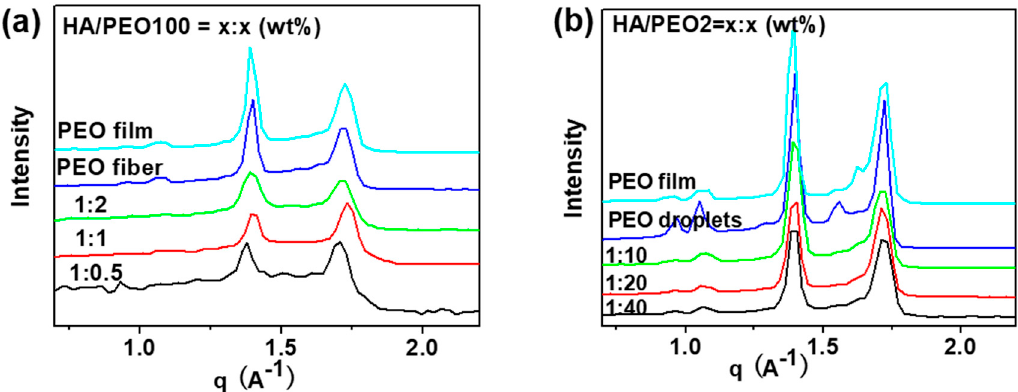
Figure 3. Wide-angle X-ray scattering (WAXS) patterns of the HA / PEO blended fibers and PEO casting films: ( a ) HA / PEO-100 blended fibers and PEO-100 fibers and casting film; and ( b ) HA / PEO-2 blended fibers and PEO-2 droplets and casting film.